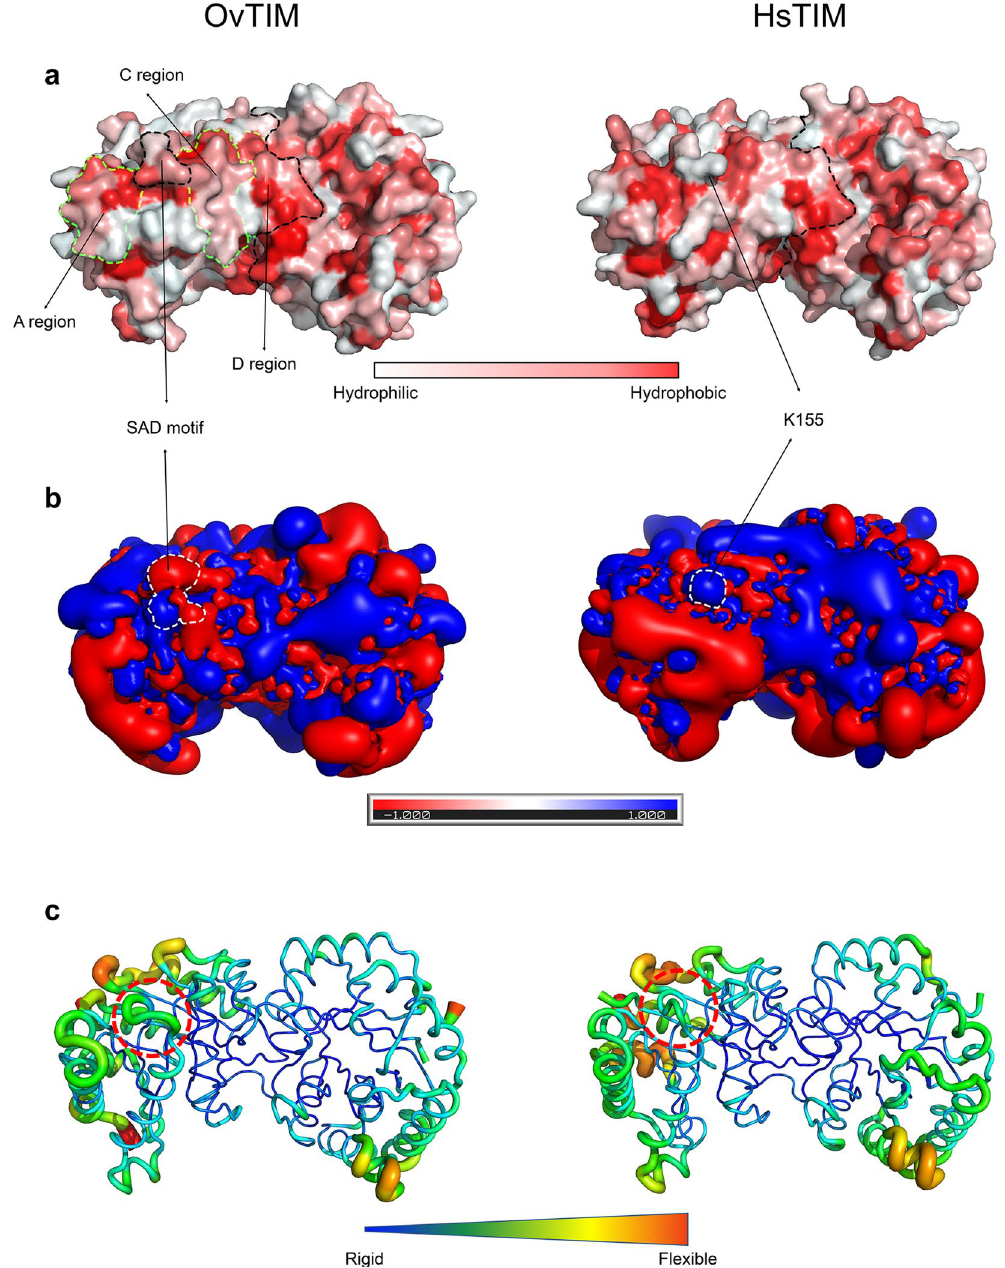
Figure 4. Comparison of surface characteristics between OvTIM and HsTIM. ( a ) Hydrophobicity of the 4 hydrophobic regions comprising the long hydrophobic patch in OvTIM is represented as dotted lines. ( b ) Electrostatic field, the SAD motif in OvTIM and K155 in HsTIM are designated as white dotted lines. ( c ) Temperature factor, the SAD motif in OvTIM and K155 in HsTIM are designated as red dotted